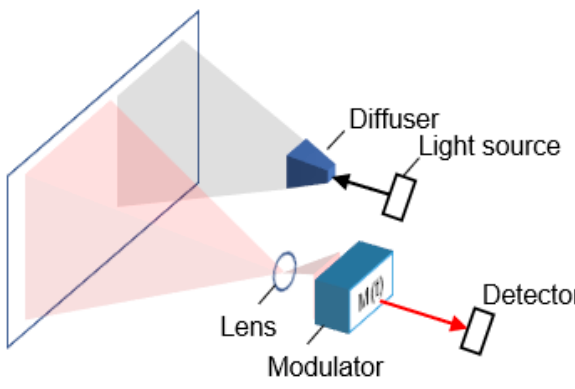
Figure 1. Scheme used by AMCW time of flight (ToF) cameras.